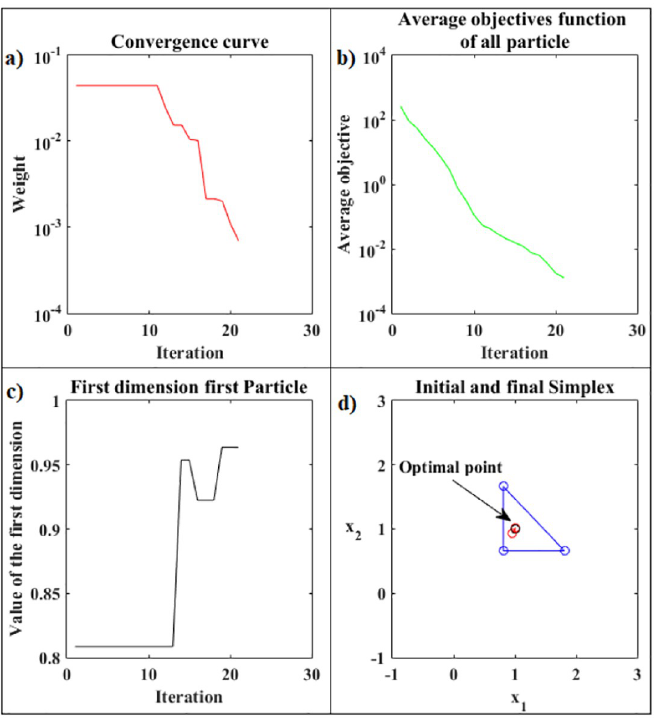
Fig 8. Rosenbrock function. Details of the optimization process of the PSO-Kmeans-ANMS algorithm in Phase 2.